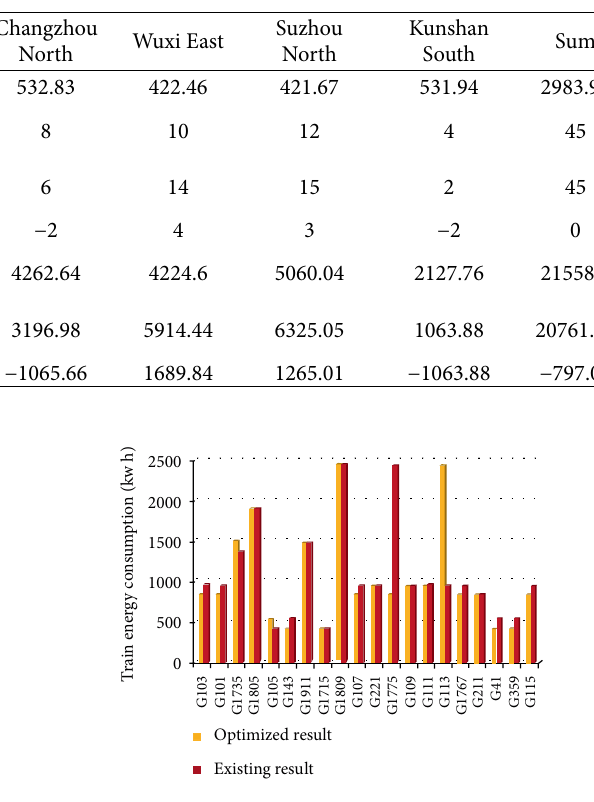
Figure 4: Comparisons on the energy consumption of each